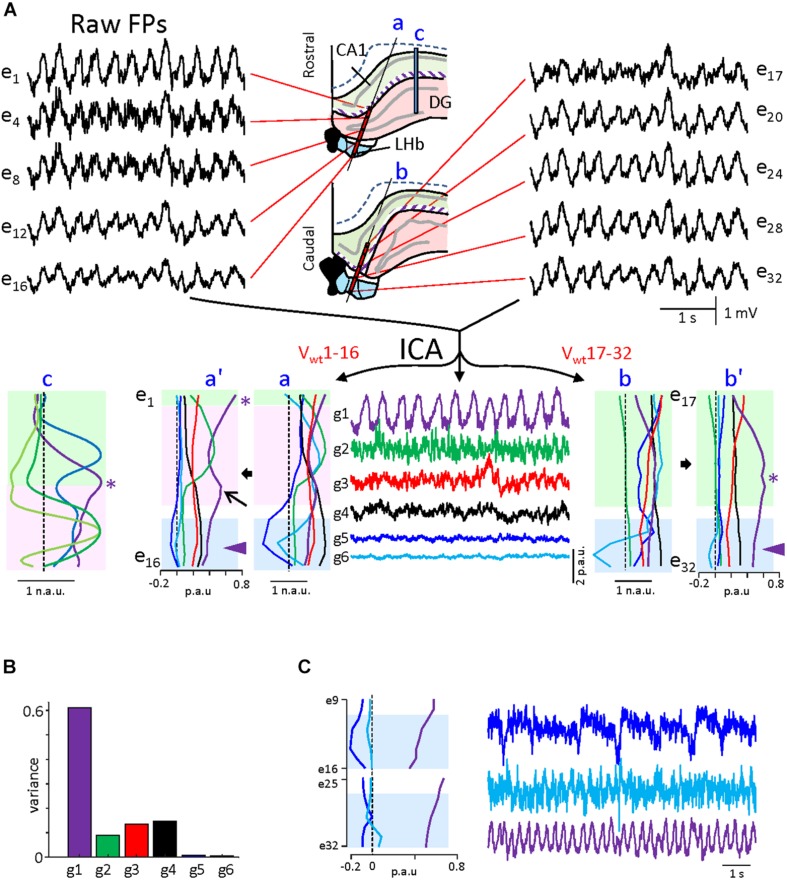
Independent component analysis of linear field potentials (FPs) during theta in experiment 1. (A) Sample FPs recorded in the two arrays at the locations indicated in the drawings of the middle panels taken from histological samples. The purple strip marks the position of the apical distal dendrites of the CA1 (st. lac-mol), which is the main source of theta activity in the hippocampus. The middle panel in the lower row shows the time course of the independent component analysis (ICA)-separated generators. The corresponding V-profiles (Vwt) are at both sides in normalized (a,b) and proportional units (a’,b’). The proportional units provide a quantitative estimation of the relative contribution of each generator on each site. Since some generators are too weak, the normalized curves facilitate visual matching of the voltage gradients to anatomical boundaries. Colored zones denote the different regions spanned by the electrodes. Only g1 displayed theta activity, and in it presented max power at the st. lac-mol. in all arrays (asterisks). Note that the shape of the V-profiles reflects the relative orientation of the linear array and the anatomical spatial boundaries of the source [compare to the V-profiles obtained from ICA of recordings made orthogonal to the planar portions of cell layers in (c)]. The arrow points to a partial maximum in the stratum moleculare of the dentate gyrus (DG), indicating a second source for theta in this region. The theta generator decays smoothly across the habenula (arrowheads), indicating volume conduction from outer sites. The DG generator (g2) contains mostly gamma activity and it peaked in the hilar region because of the granule cell layer folding [note it has no power in array (b)]. (B) Relative variance contributed by each generator. Those with maxima in the LHb (g5 and g6) were negligible (<1%). (C) Reanalysis of the same data for chosen FPs around the LHb regions. The LHb enriched FPs yielded similar generators, while the increased variance makes them more reliable. The g5 displays irregular activity and slow spikes, while g6 shows sporadic theta modulation. The asterisks in (a–c) V-profiles mark an equivalent site in the CA1 st. lac-mol.